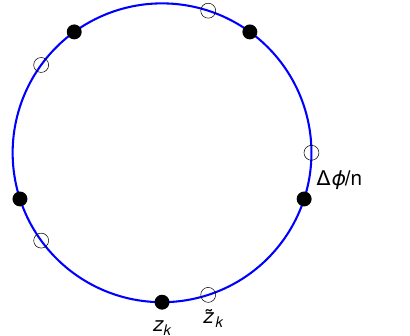
Figure 9: Wick contraction in (5.59) of the 10 operators needed to compute the 5th Renyi entropy [ 38 ]